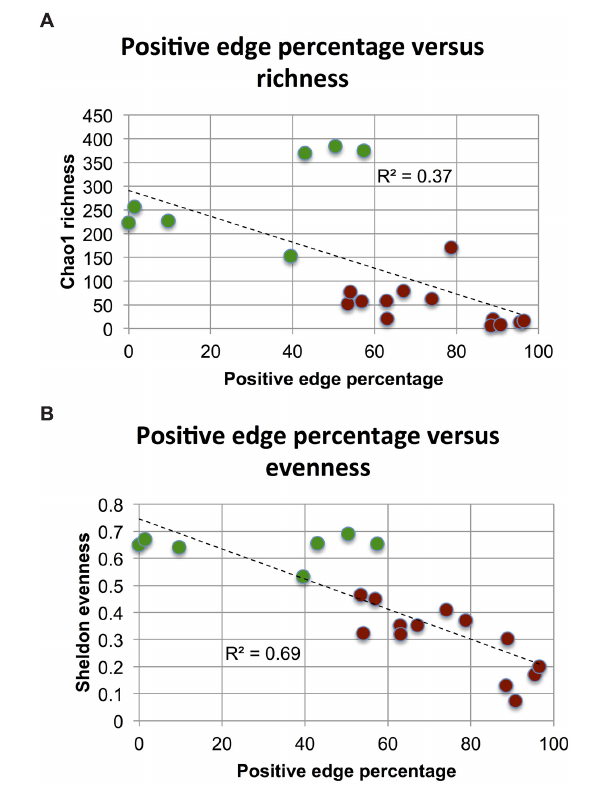
FIGURE 4 | Impact of richness and evenness. When assessing richness (using median Chao1) and evenness (using median Sheldon’s index) in 20 (processed and rarefied) soil and host biomes, richness is found to be weakly anti-correlated (A) and evenness strongly anti-correlated to PEP (B) . Host data is colored in brown, soil data in